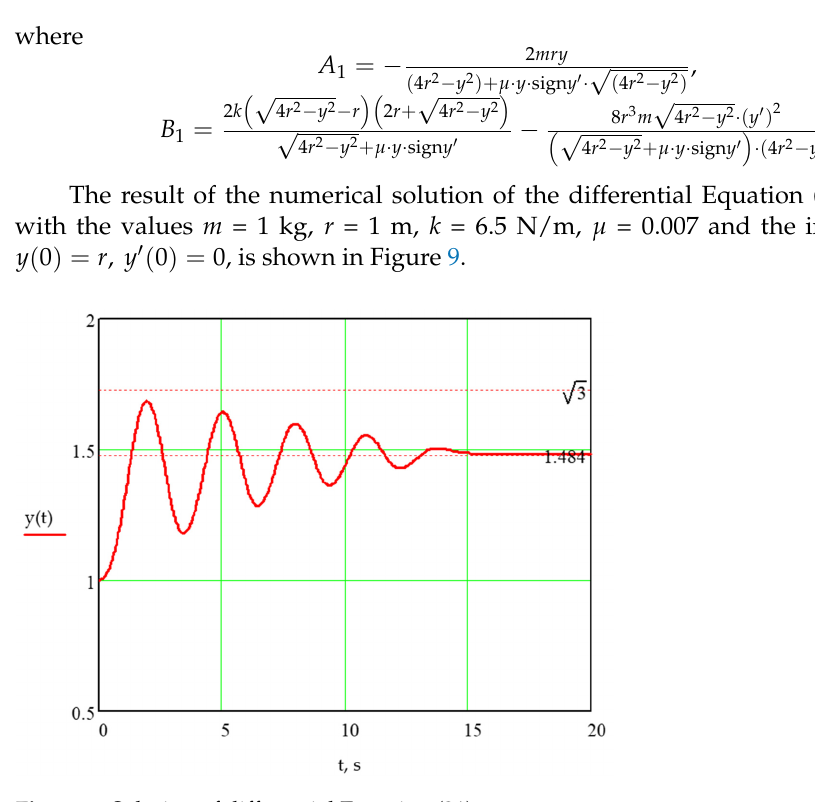
Figure 9. Solution of differential Equation